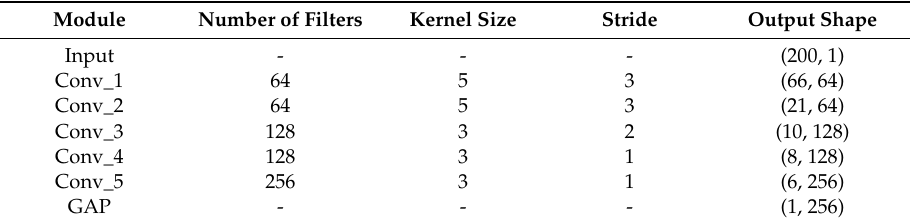
Table 2. Convolutional layer parameters in the window feature learning